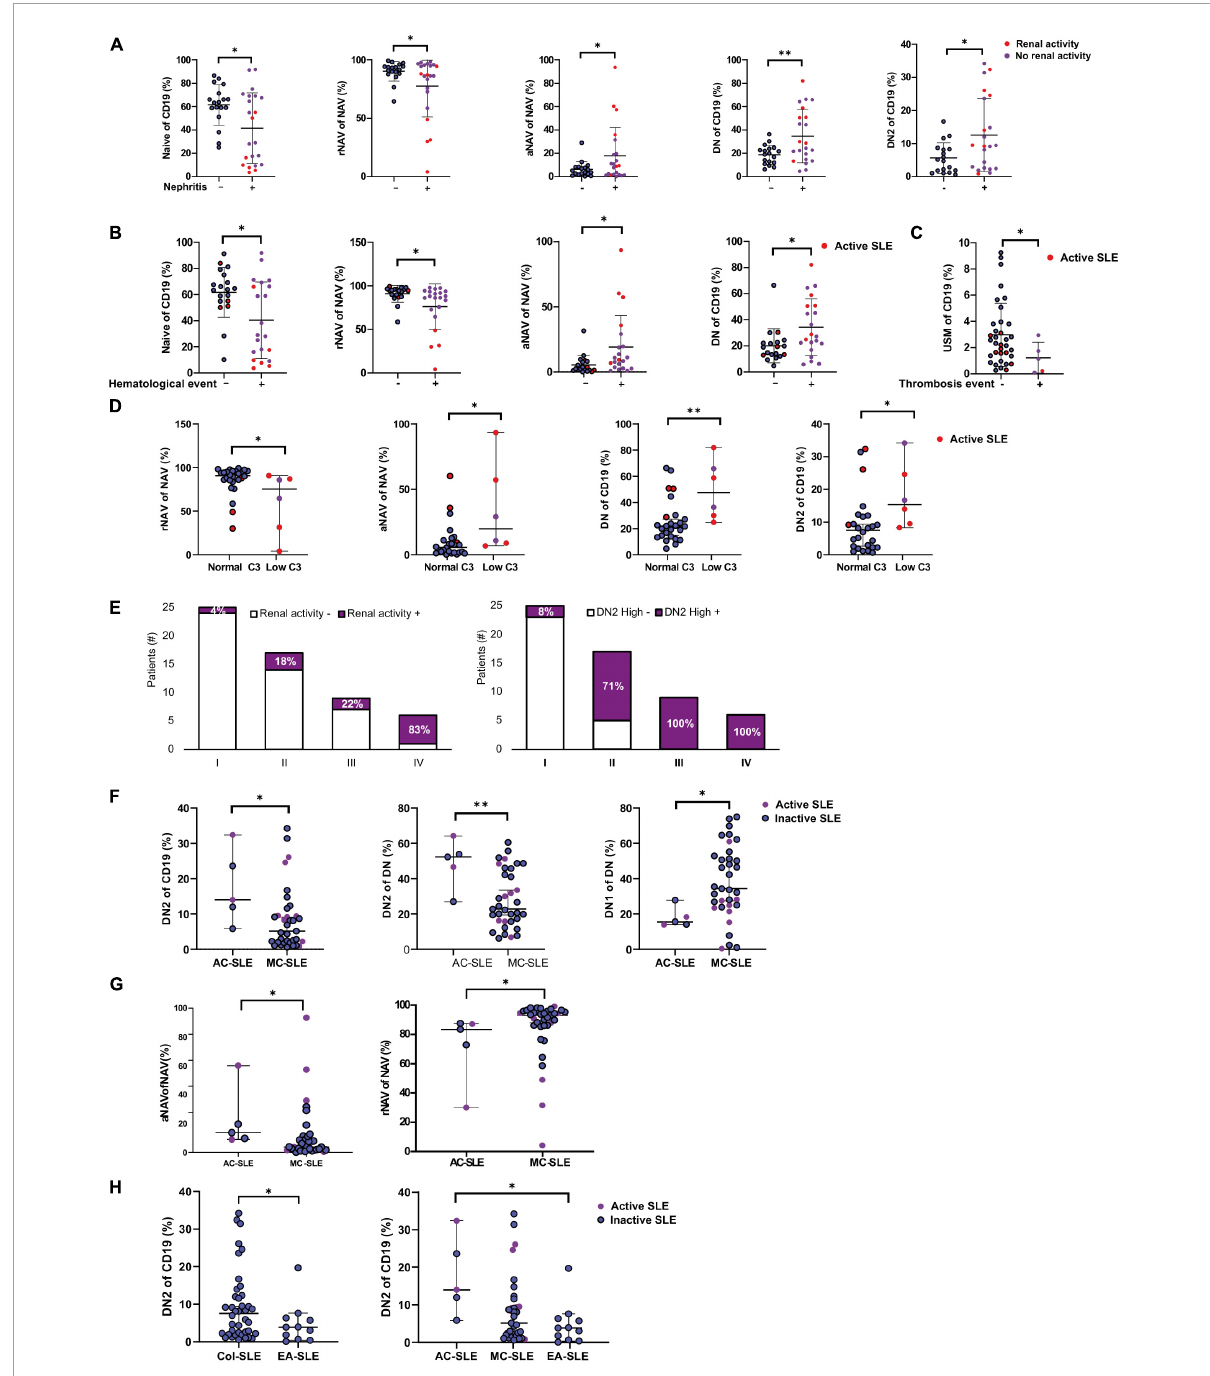
FIGURE3 B cell subsets distribution on patients and clinical associations. (A) B cell subpopulations associated with nephritis. Mann–Whitney T -test was used for analysis, and median and 95% CI are depicted in the figures. (B) B cells are associated with a history of hematologic involvement. Mann–Whitney T -test was used for analysis, and median and 95% CI are depicted in the figures. (C) Association of USM cells in patients with a history of thrombosis Mann–Whitney T -test was used for analysis, and median and 95% CI are depicted in the figures. (D) B cells subsets associated to low C3 levels. Mann–Whitney T -test was used for analysis, and median and 95% CI are depicted in the figures. (E) Clinical characteristics associated with clusters identified in Figure 1E : renal activity and high DN2 values; the Chi-square test were used for analysis. (F) Ethnicity and DN1 and DN2 Cells. AC, African Colombian; MC, Mestizo Colombian. Mann–Whitney T -test was used for analysis, and median and 95% CI are depicted in the figures. (G) Ethnicity and rNAV and aNAV Cells. Mann–Whitney T -test was used for analysis, and median and 95% CI are depicted in the figures. (H) Ethnicity and DN1 and DN2 Cells in Colombian and European American SLE patients. Mann–Whitney T -test and Kruskal Wallis was used for analysis, and median and 95% CI are depicted in the figures. * P ≤ 0.05; ** P ≤ 0.01; *** P ≤